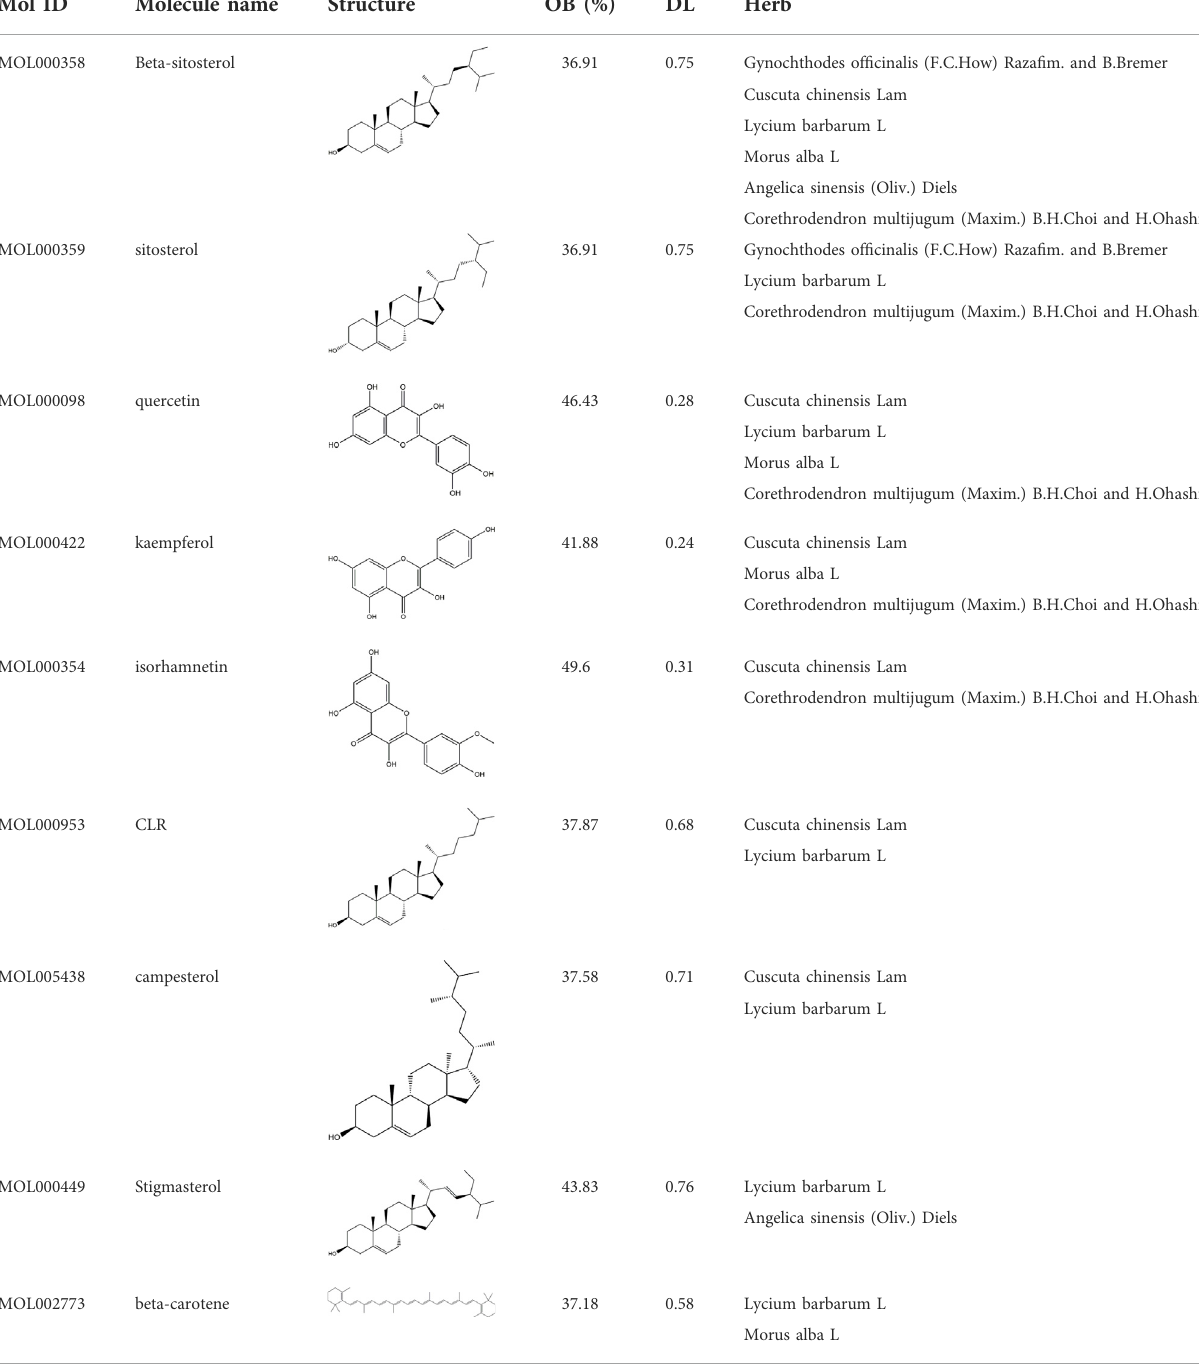
TABLE 3 The components with more than one occurrence in different herbs of CCMM in TCM